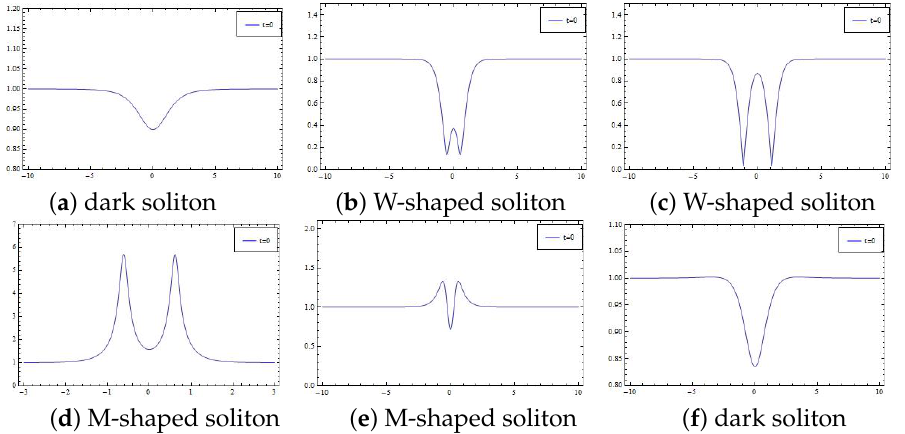
: ( a ) dark soliton 5 , ( d ) M-shaped 10 2